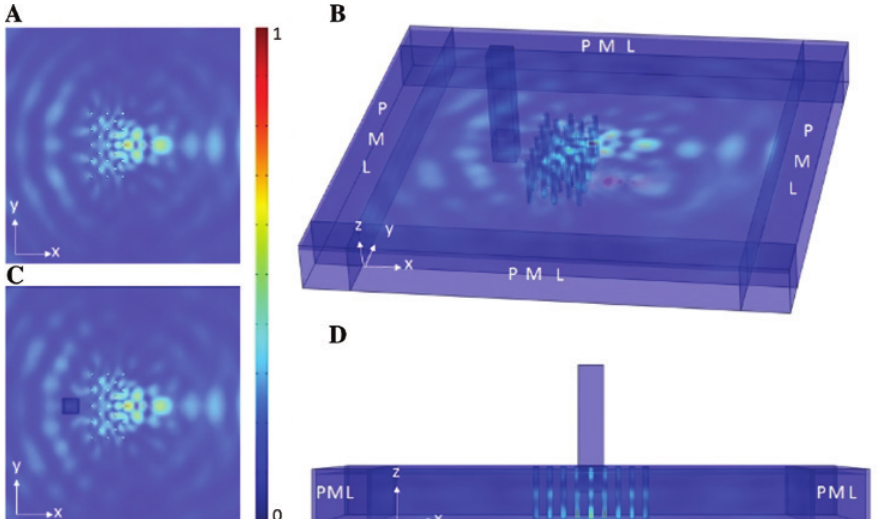
Figure 2: Finite element simulations for a plate 15 m in thickness with transverse dimensions 120 m × 120 m (including perfectly matched layers, 20 m in width) with elastic soil parameters like those in Figure 1 for a seismic source of time-harmonic frequency 12 Hz shows a shielding effect by the array (pitch 7 m) of boreholes (2 m in diameter, 15 m in depth); (A) Top view of magnitude of displacement field for boreholes on their own. Note the vanishing displacement field amplitude just behind the array of boreholes. (B) 3D view for magnitude of displacement field for boreholes with a building (similar to that in Figure 12) protected behind this array; (C) Top view of (B); (D) Side view of (B). Color scale ranges from dark blue (vanishing) to red (maximum) magnitude of displacement field and is normalized the source, to facilitate comparison with Figure